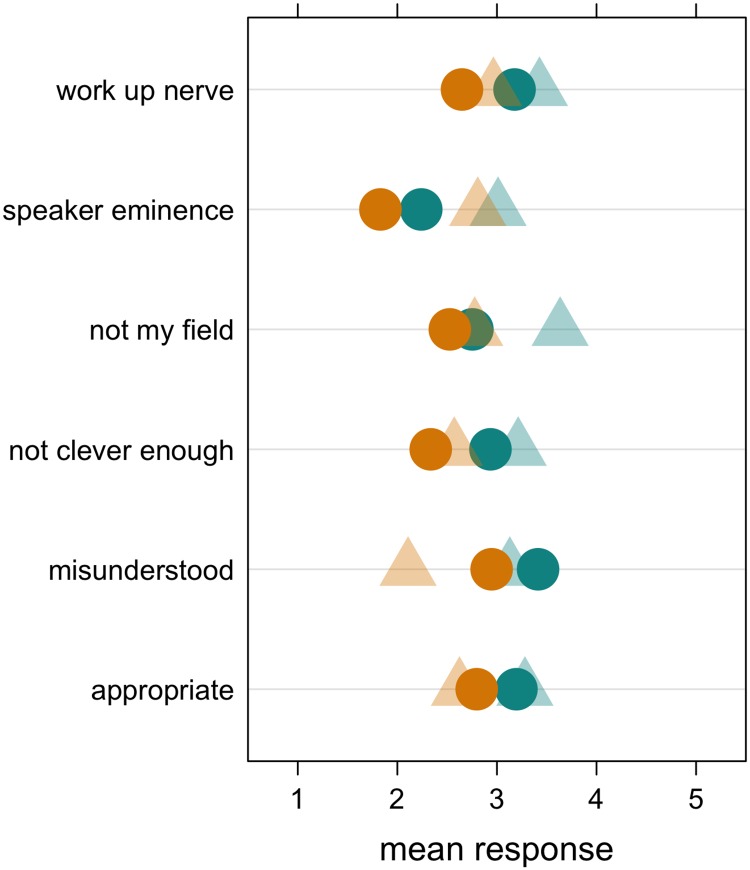
Mean importance assigned by women and men to (1) each reason why they themselves have not asked a question in a seminar when they wanted to, and to (2) each reason men and women believe women do not ask questions when they want to.Shown are the mean values for women (green) and men (orange) rating how important each factor is in restricting why they themselves did not ask questions when they wanted to (circles). For the respondents who reported a belief that women ask fewer questions than men, shown are the mean values for women (green) and men (orange) rating how important each factor is in restricting women from asking questions when they wanted to (triangles).